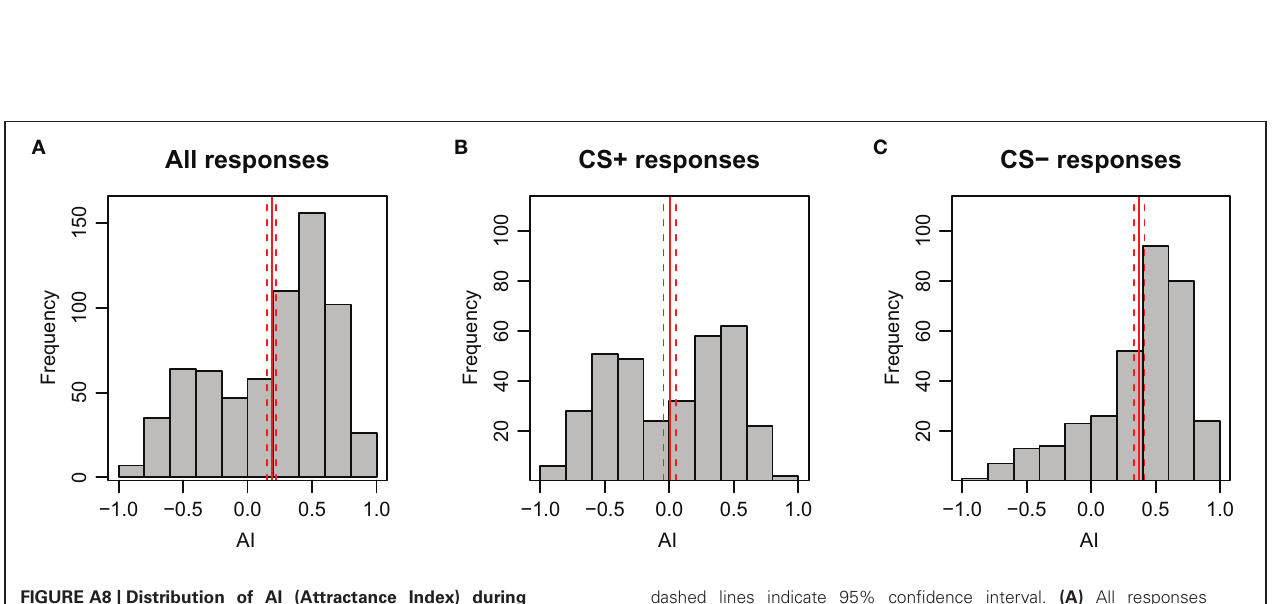
FIGURE A8 | Distribution of AI (Attractance Index) during stimulation period of the test phase for bees in APIS. As expected, the AI is skewed to positive values during presentation of the CS − . The solid red lines indicate the mean side preference; the